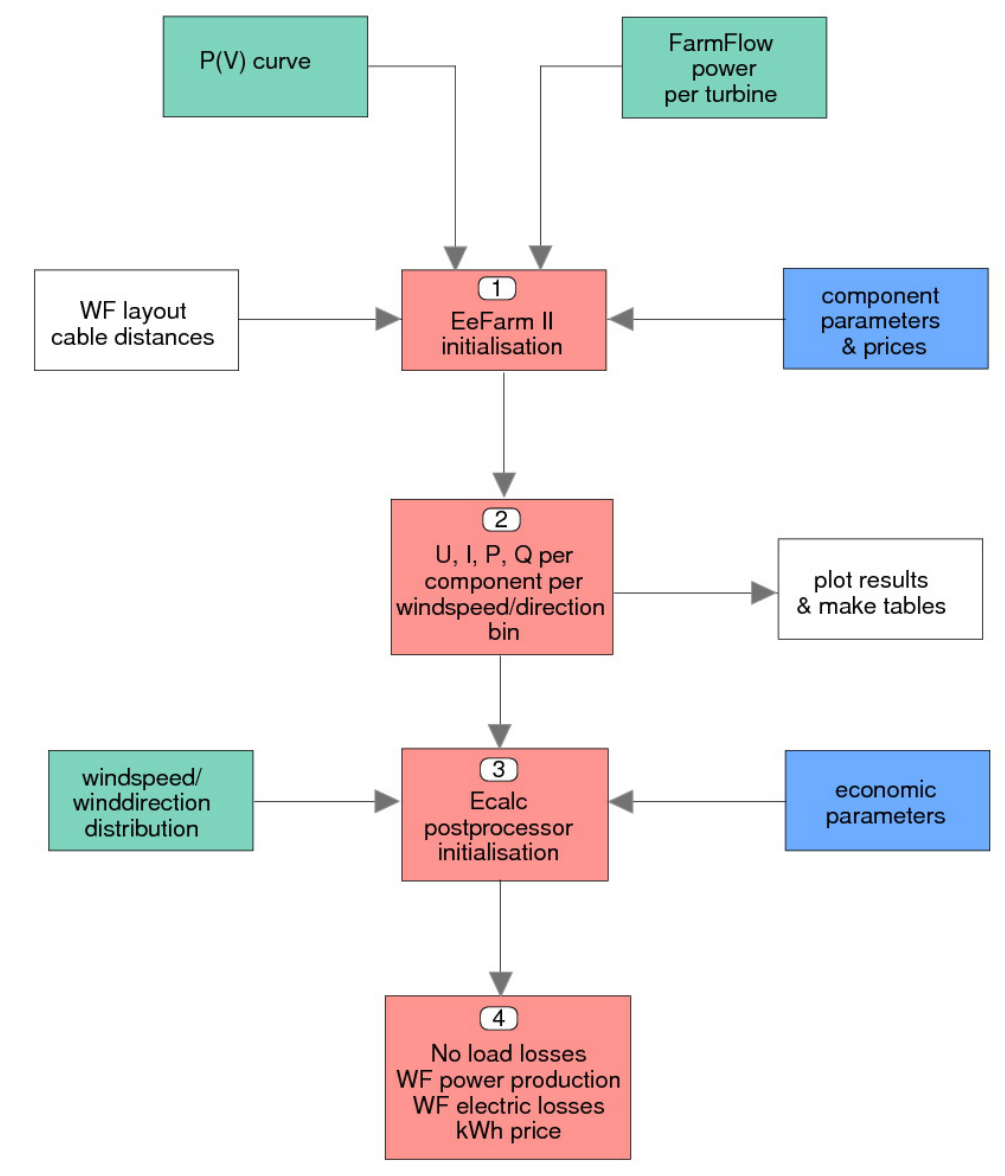
Figure 2 . EeFarm II model